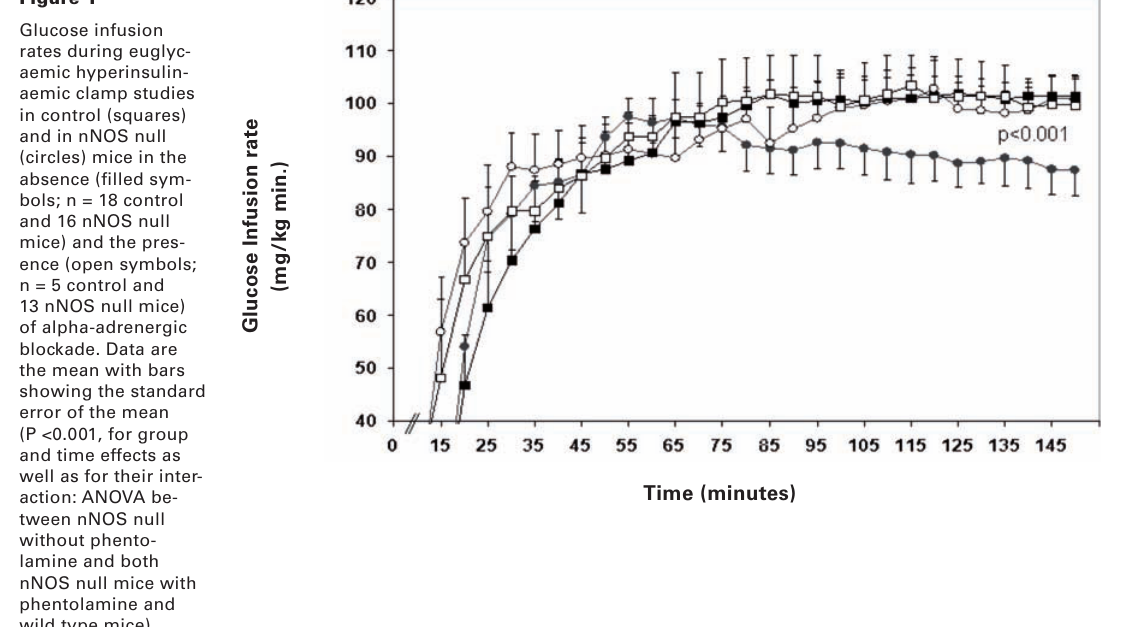
Glucose infusion rates during euglyc - aemic hyperinsulin - aemic clamp studies in control (squares) and in nNOS null (circles) mice in the absence (filled sym- bols; n = 18 control and 16 nNOS null mice) and the pres- ence (open symbols; n = 5 control and 13 nNOS null mice) of alpha-adrenergic blockade. Data are the mean with bars showing the standard error of the mean (P <0.001, for group and time effects as well as for their inter- action: ANOVA be- tween nNOS null without phento- lamine and both nNOS null mice with phentolamine and wild type